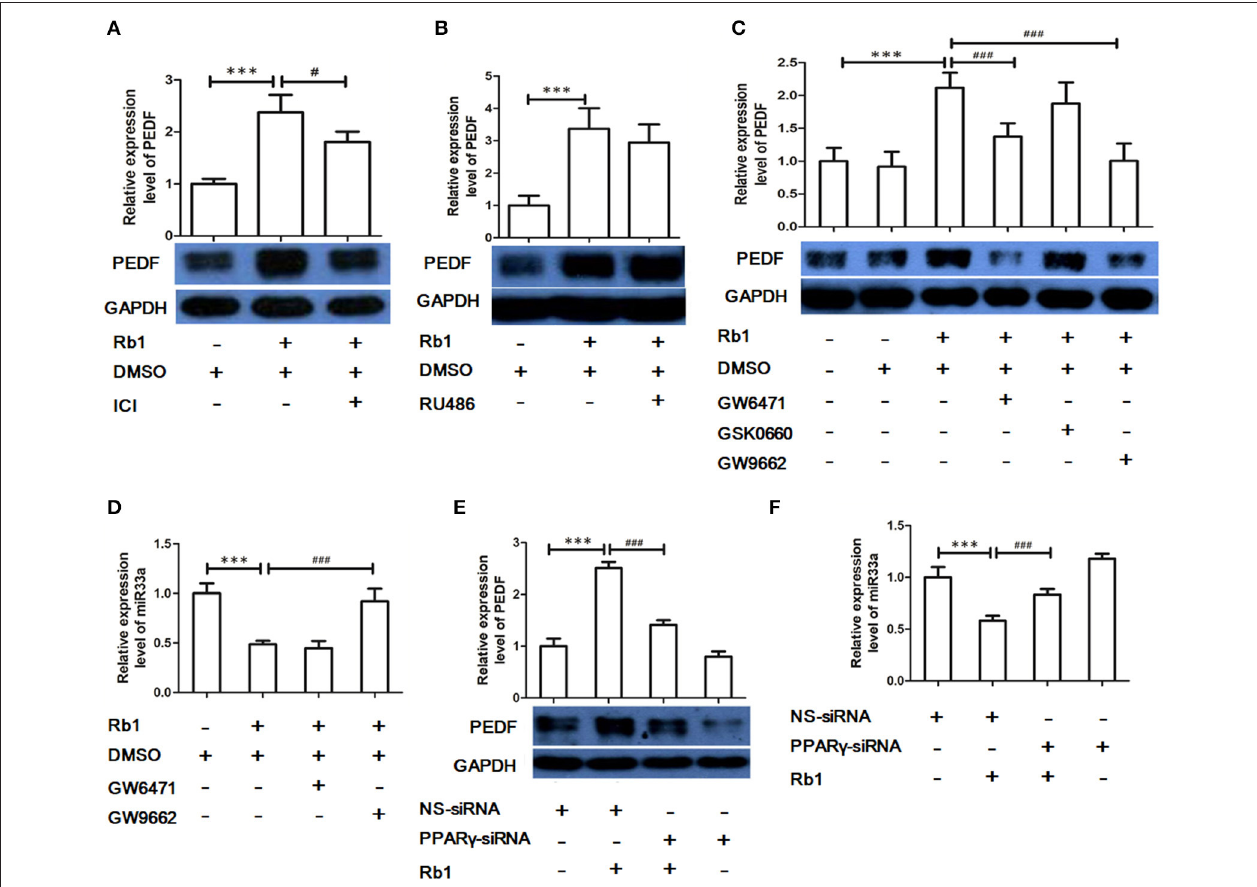
FIGURE 4 | The role of nuclear receptors in Rb1-mediated regulation of miR-33a and PEDF. (A) PEDF expression in HUVECs pre-treated with estrogen receptor (ER) antagonist ICI 182,780 (ICI, 20 µ M) before Rb1 stimulation. (B) PEDF expression in HUVECs pre-treated with Glucocorticoid receptor (GR) antagonist (RU486, 5 µ M) before Rb1 stimulation. (C) PEDF expression in HUVECs pre-treated with PPAR α antagonist (GW6471, 10 µ M), PPAR β antagonist (GSK0660, 10 µ M), or PPAR γ antagonist (GW9662, 10 µ M) before Rb1 stimulation. (D) Effect of PPAR α antagonist (GW6471), PPAR γ antagonist (GW9662) on miR expression. (E) Effect of PPAR α and PPAR γ -siRNA on PEDF expression. HUVECs were transiently transfect with treated with PPAR α -siRNA (40nM) and PPAR γ -siRNA (40nM) for 24h before treatment of Rb1 (10nM). (F) Effect of PPAR α and PPAR γ -siRNA on miR-33a expression. HUVECs were transiently transfect with treated with PPAR α -siRNA (40nM) and PPAR γ -siRNA (40nM) for 24h before treatment of Rb1 (10nM). The relative expressions of miRNAs were calculated against U6 RNA using the comparative Ct method (2 − 11 Ct ). Each value was expressed as fold of control mean + S.E.M ( n = 3). *** p < 0.001 vs. con; # p < 0.05, ### p < 0.001 vs. Rb1 treatment